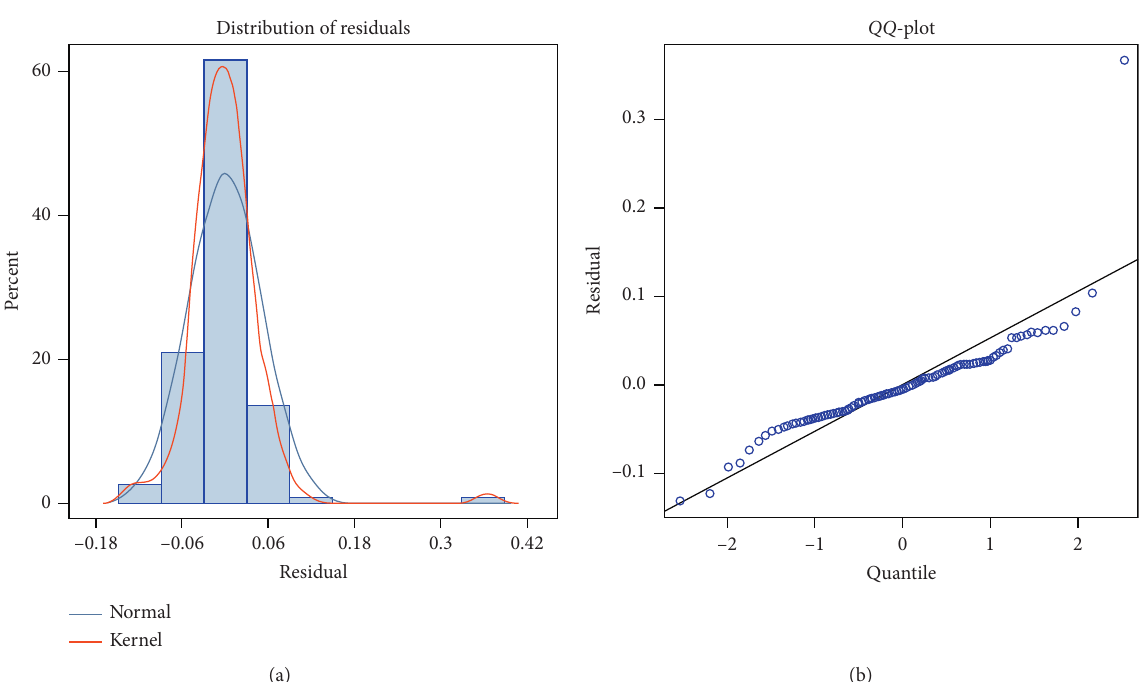
Figure 5: Autocorrelation diagnosis diagrams of the residual error of the RDL model after green finance